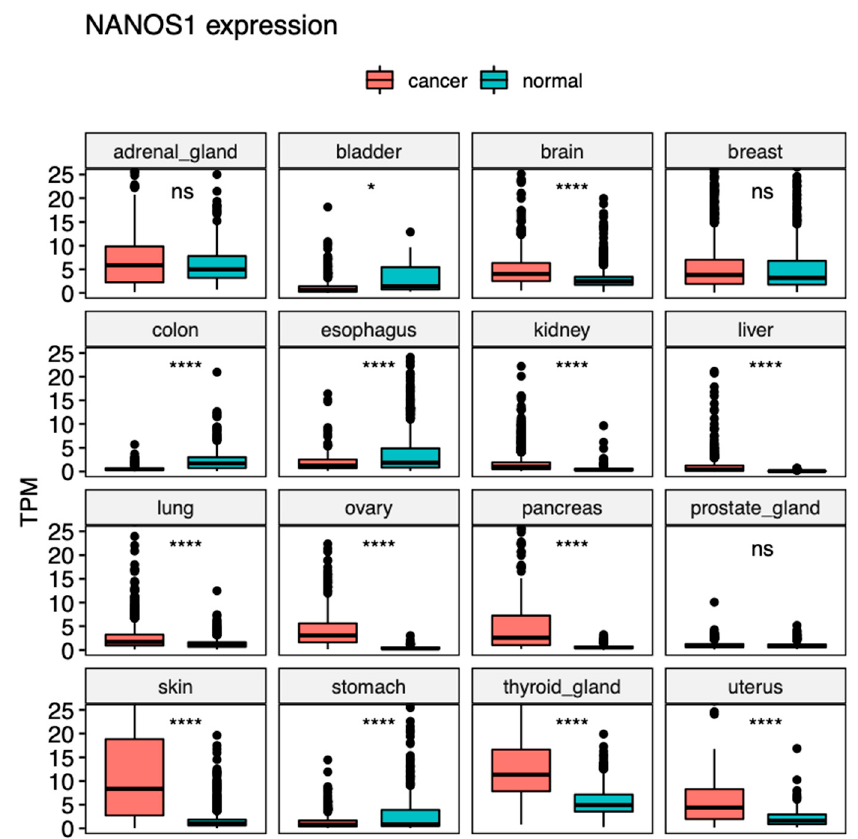
Figure 2. NANOS1 expression across human cancers. Box-plot comparison of transcripts per million (TPM) expression values obtained from RNA-Seq experiments in cancer (TCGA) (red boxes) and normal tissues (GTEx) (blue boxes). Statistical significance was determined using a two-tailed t -test. ns = non-significant, * = p < 0.05, **** = p < 0.0001.